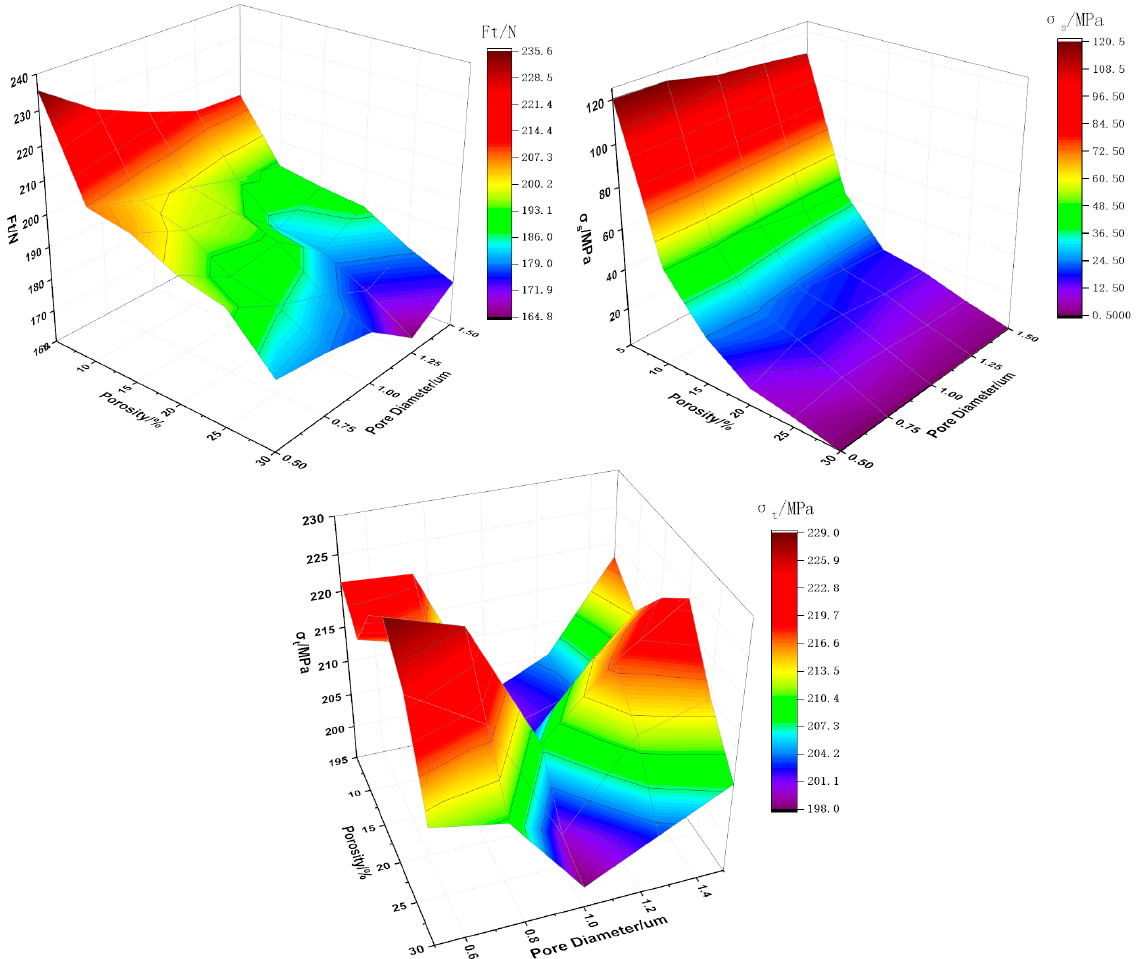
Figure 14. Simulation results of the coating properties under different work conditions.